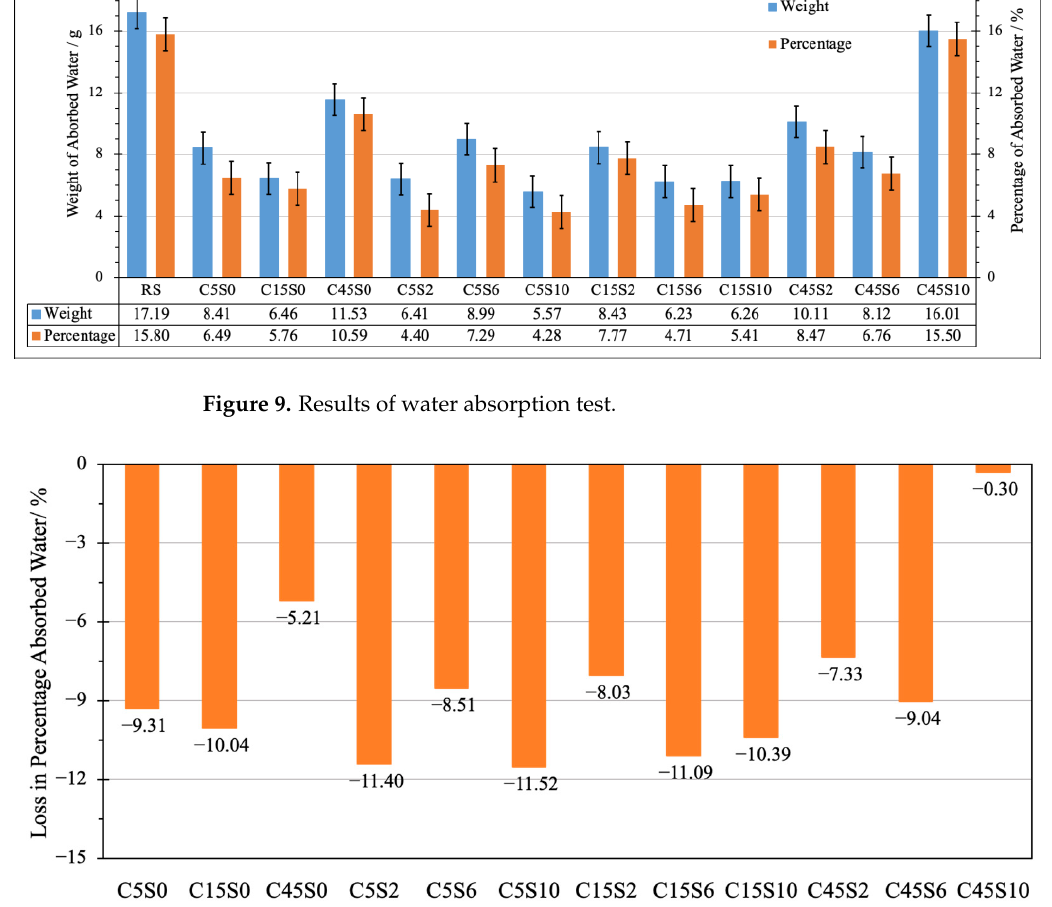
Figure 9. Results of water absorption test.